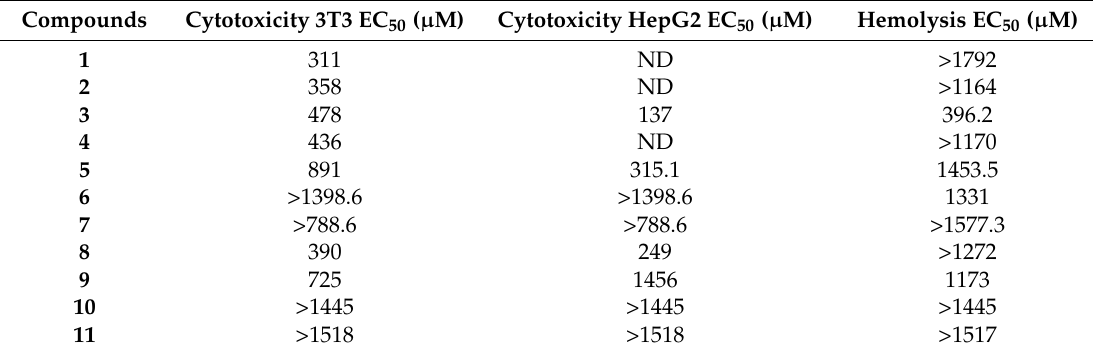
Table 3. Cytotoxicity and hemolytic activity of HDP mimetics.